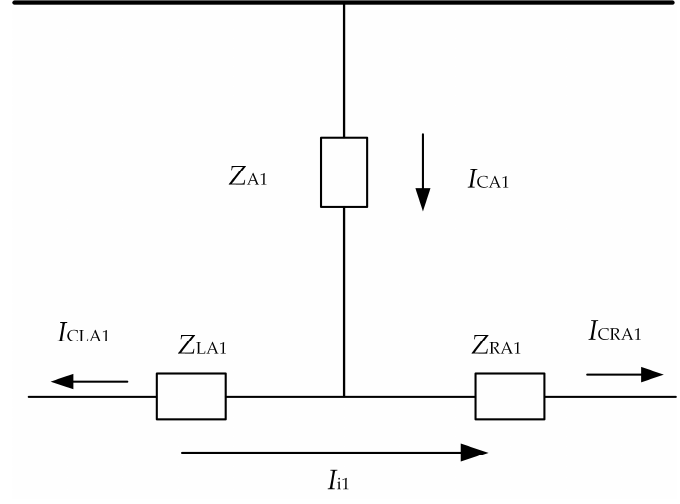
Figure 3. The A1 minor section cable equivalent two-port network.